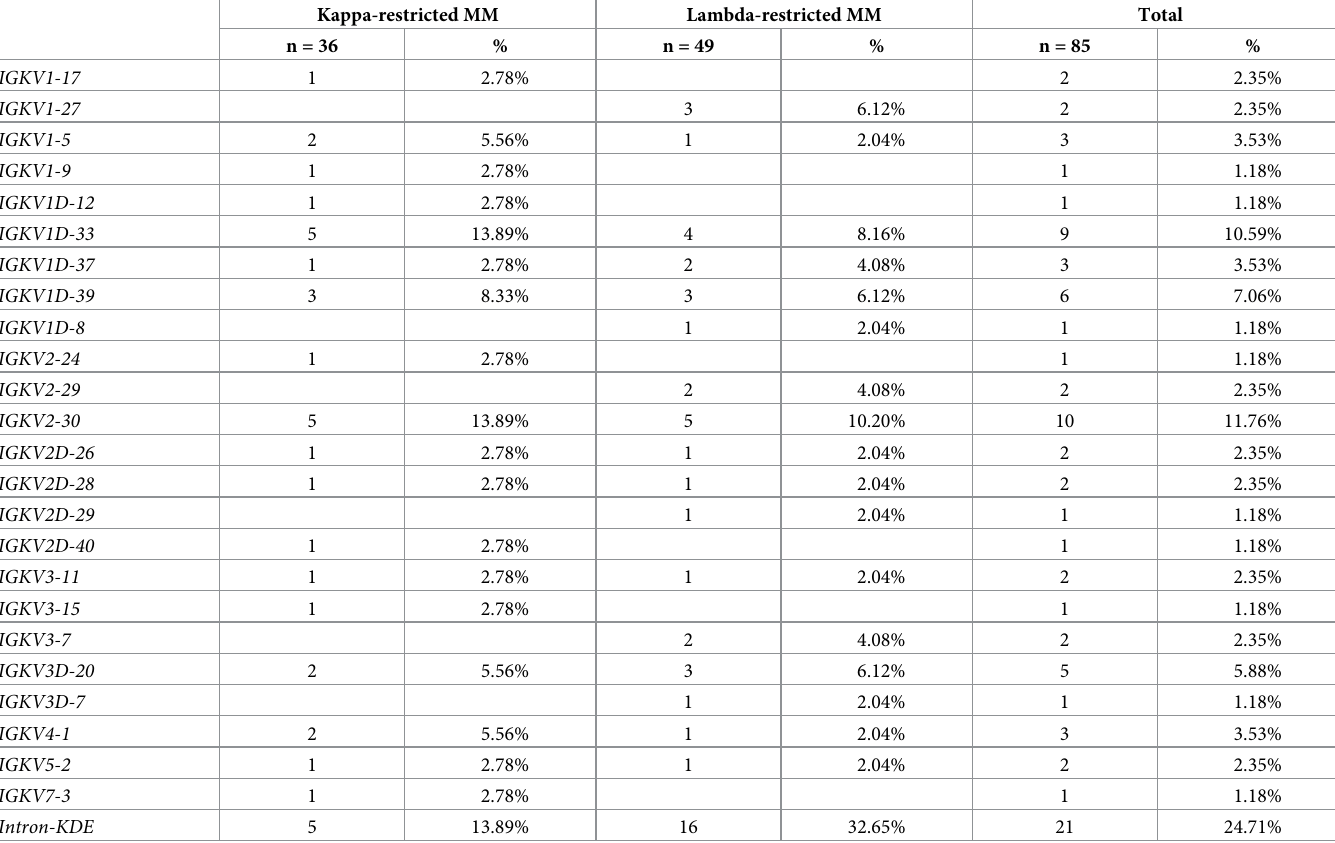
Table 6. The IGKV ( D ) gene repertoire in 85 igk rearrangements from 40 samples with clonal igk